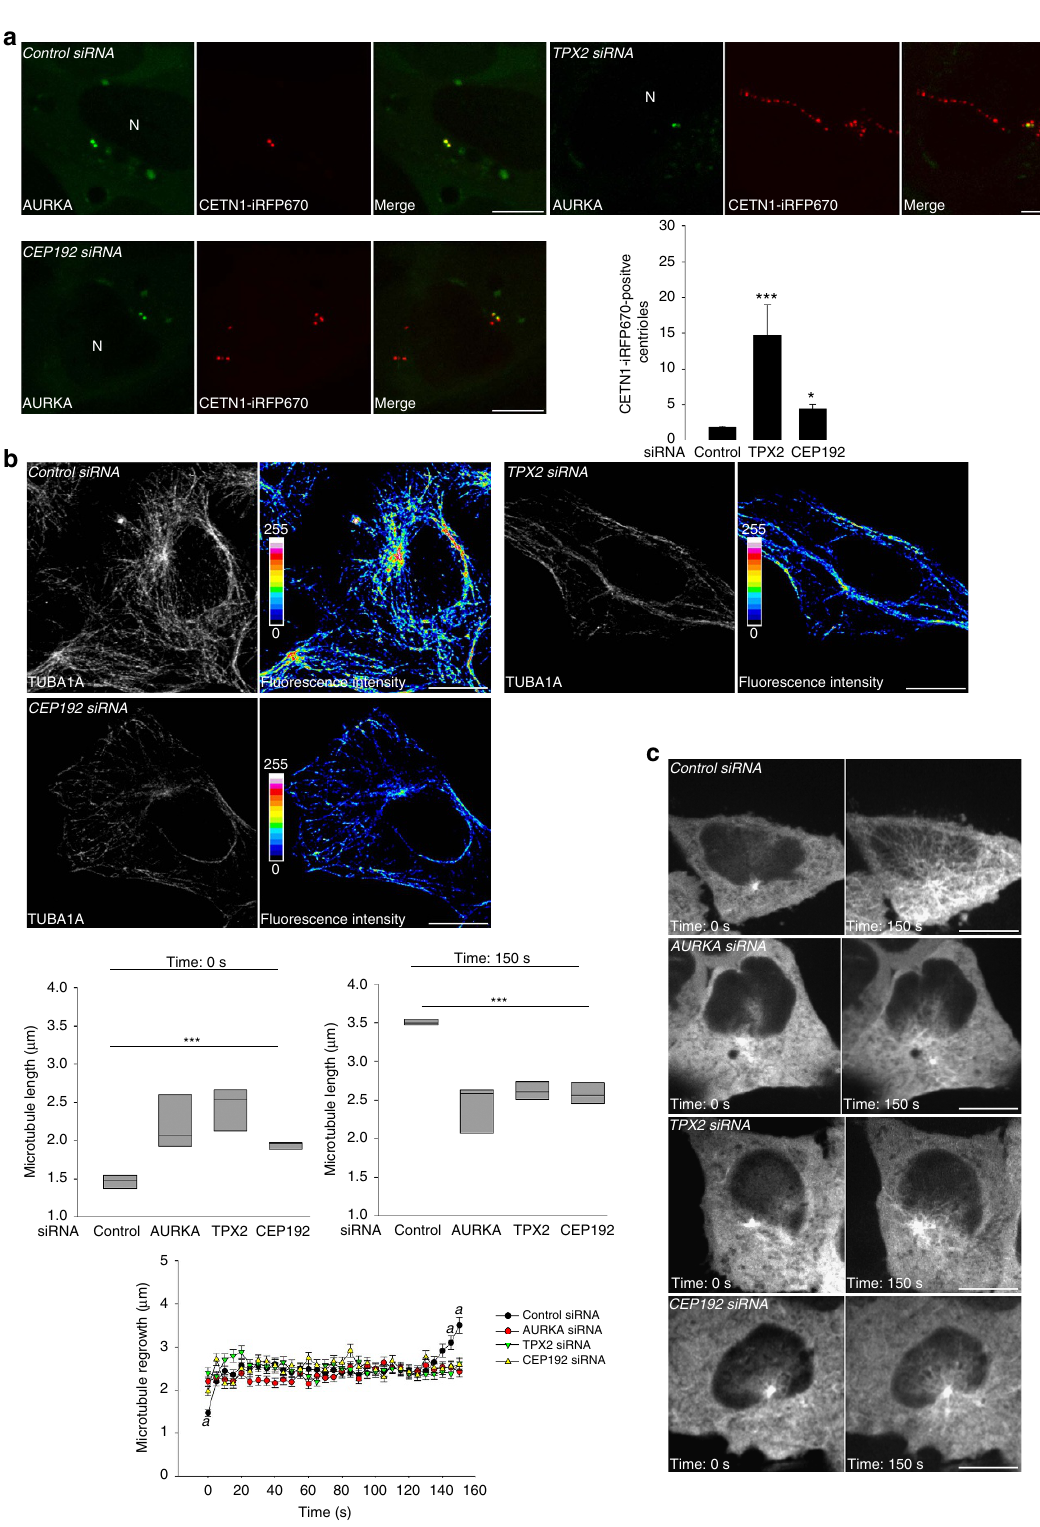
Figure 7 | Microtubule dynamics of G1 cells is altered in the absence of TPX2 or CEP192. ( a ) Representative immunofluorescence micrographs and corresponding quantification of centriole amplification in GFP-AURKA-mCherry cells depleted for TPX2 or CEP192, and synchronized in G1. Centrioles were labelled with CETN1-iRFP670. n ¼ 30 cells per condition from three independent experiments. ( b ) Immunofluorescence images of the TUBA1A network in cells transfected and synchronized as in a . The pseudocolour scale represents the measure of the intensity of the TUBA1A staining. ( c ) Representative time-lapse images and corresponding boxplots of the regrowth of the microtubule network at 0 and 150s after nocodazole-mediated depolymerization in HeLa GFP-TUBA1A cells transfected with the indicated siRNAs. Line graph: complete time-lapse analysis of the microtubule regrowth. n ¼ 30 cells per condition from three independent experiments. N, nucleus. Scale bar, 10 m m in a , b , 5 m m in c . Data represent means ± s.e.m. * P o 0.05, *** P o 0.001 against the ‘control siRNA’ condition in a , c , a P o 0.01 against the corresponding time-points in all other conditions. Statistical tests: one-way